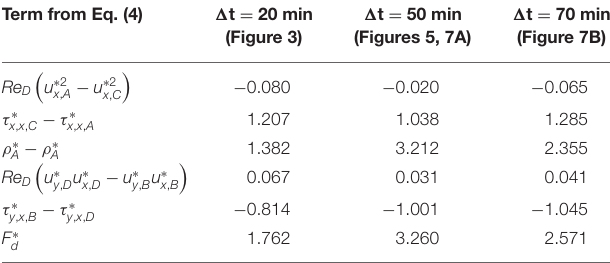
TABLE 1 | Magnitudes of terms in the momentum balance Eq. (4) and the viscous drag coefficients F * d for the drop 20, 50, and 70min after the first encounter with bacteria. Term from Eq.